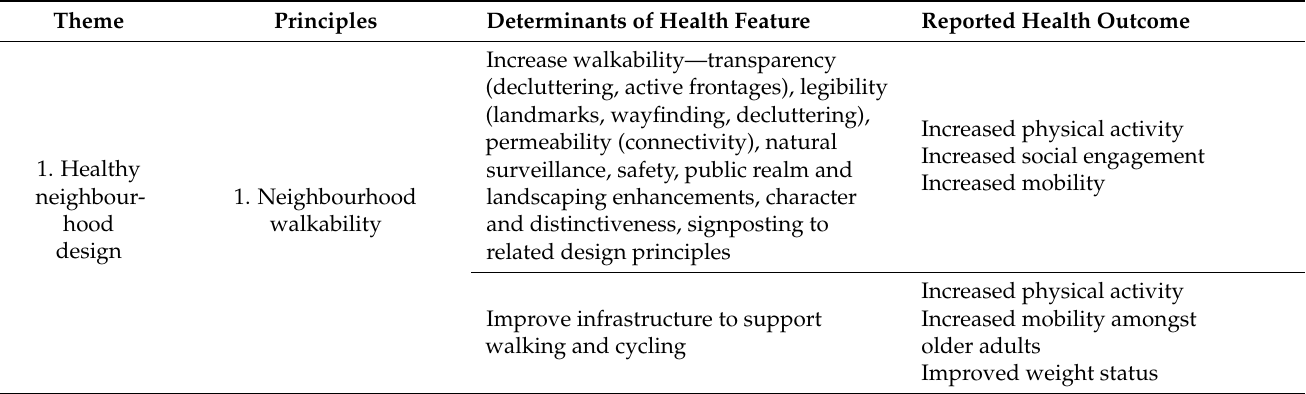
Table A2. Determinants of health features, adapted from Bird et al. (2018)